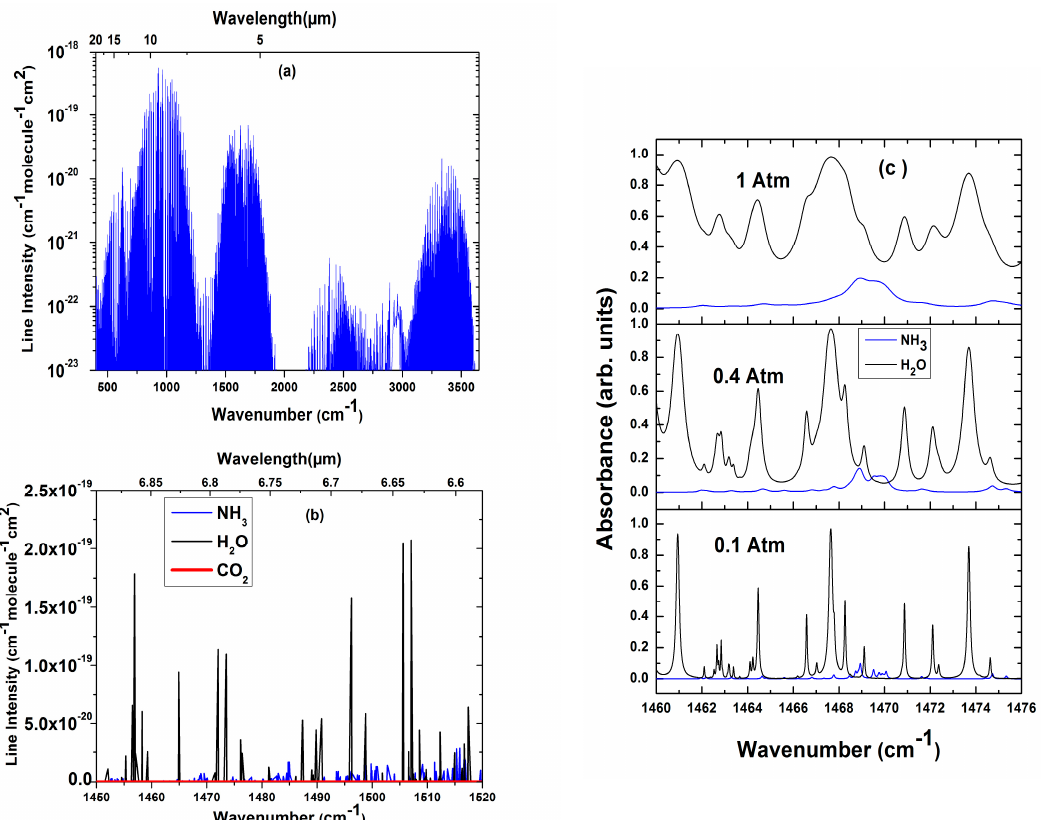
Figure 4. ( a ) HITRAN simulation lines intensities of NH 3 in the wavelength range from 2.5 µm to 25 µm, ( b ) HITRAN simulation line intensities of NH 3 , CO 2 and H 2 O around 1470.58 cm − 1 , ( c ) HITRAN simulation of NH 3 (23 ppm) spectra in the wavelength range of 6.80 µm at a temperature of 296 K and pathlength of 226 m for three different pressures with H 2 O (5%) spectra.